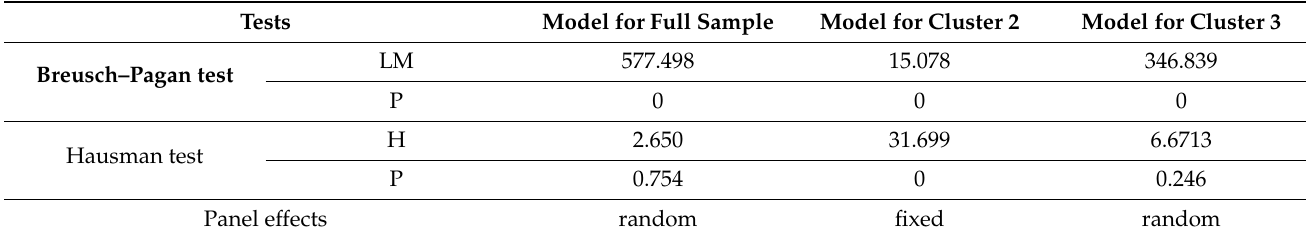
Table 5. Results of the Breusch–Pagan and Hausman tests of models with lnSR as dependent